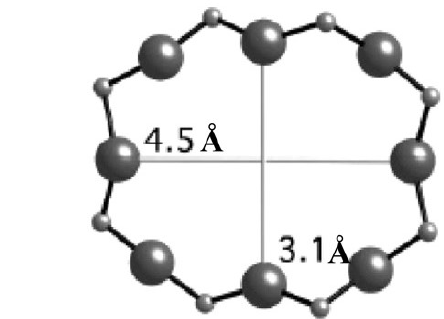
Figure 3. Structural schematic of SAPO-43 viewed along [100] ( left ) and 8-ring viewed along [100]